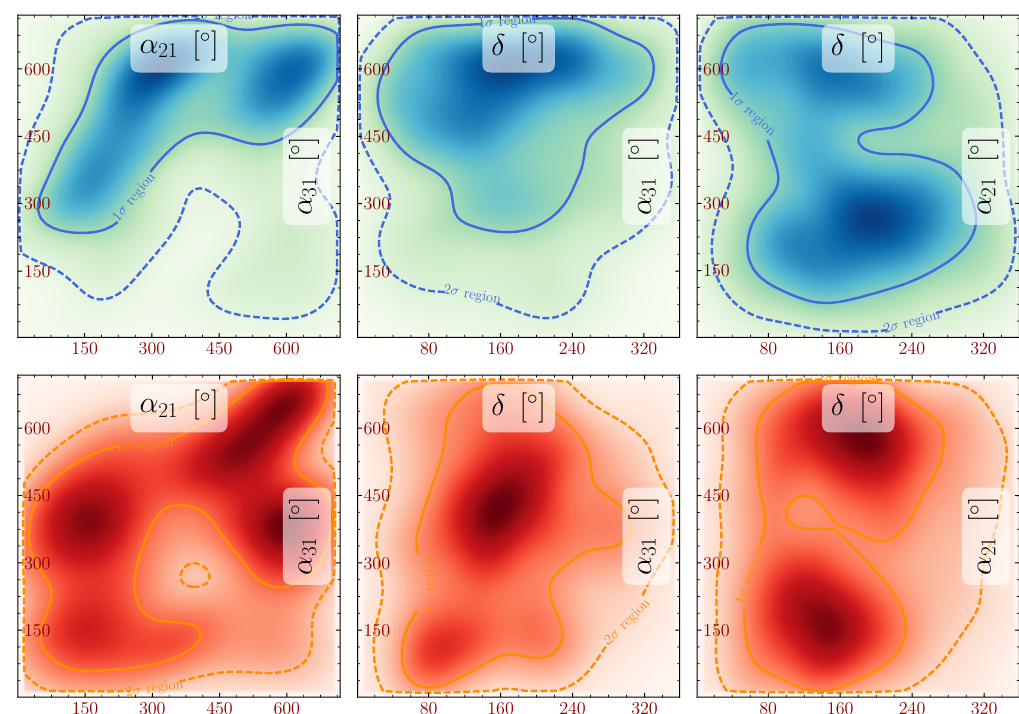
Figure 13 . The two-dimensional projections for high-scale leptogenesis with M 1 = 10 13 GeV with CP violation provided only by the phases of the PMNS matrix. The NO case is coloured blue/green and the IO one is orange/red. The contours correspond to 68% and 95% con(cid:12)dence levels. This plot was created using SuperPlot